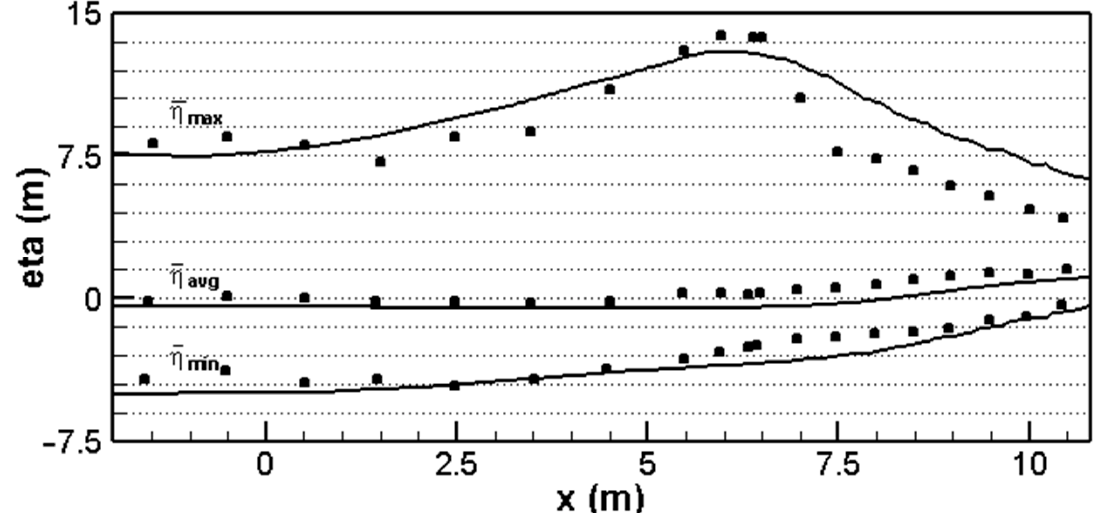
Figure 6. Results 2: minimum, average and maximum water surface elevations in Configuration WS, showing numerical results (solid line) and experimental measurements (circles) [3].